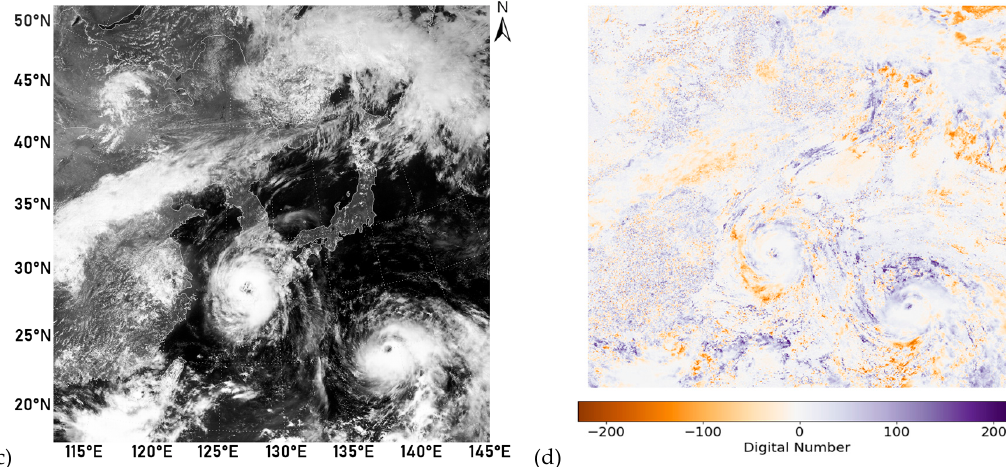
Figure 5. ( a ) Real VIS reflectance, ( b ) real IR1 radiance, ( c ) AI-generated VIS reflectance, and ( d ) difference between real VIS reflectance and AI-generated VIS reflectance. In this case, our model was trained with 80,000 iterations. The observation date and time is August 22, 2018, 04:00 UTC (daytime). Figure 6. The statistical results of our model. Figures 6a,b show the scatterplots between the COMS VIS reflectance and AI-generated VIS reflectance during winter (December 2017 to February 2018) and summer (June 2018 to August 2018), respectively. The bias, RMSE, and CC are − 2.41, 36.85, and 0.88 during summer but − 0.21, 33.02, and 0.89 during winter, respectively. In general, the bias, RMSE, and CC values are relatively higher during summer than during winter. This seasonal difference may be because of the vertical distribution of clouds, which occurs because more high clouds form during summer than during winter. The noisy vertical line with x = 225 is originated from the dotted lines of latitude/longitude and solid borderlines on the COMS VIS original image provided by the Korean Meteorological Administration (KMA)/National Meteorological Satellite Center (NMSC), which cannot be removed in this study.